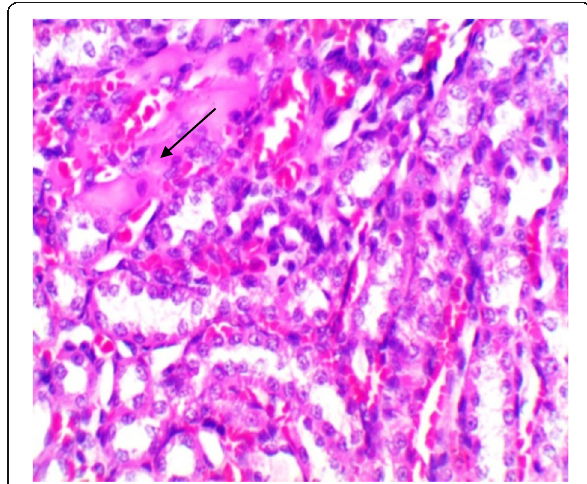
Fig. 13 Photomicrograph of CCl4-treated kidney sections showing individual tubular lining cells are enlarged and filled with eosinophilic